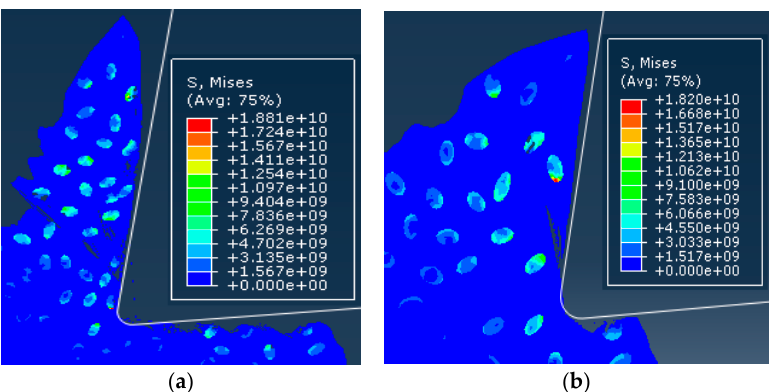
Figure 24. Comparison of cutting force for different cutting speeds.